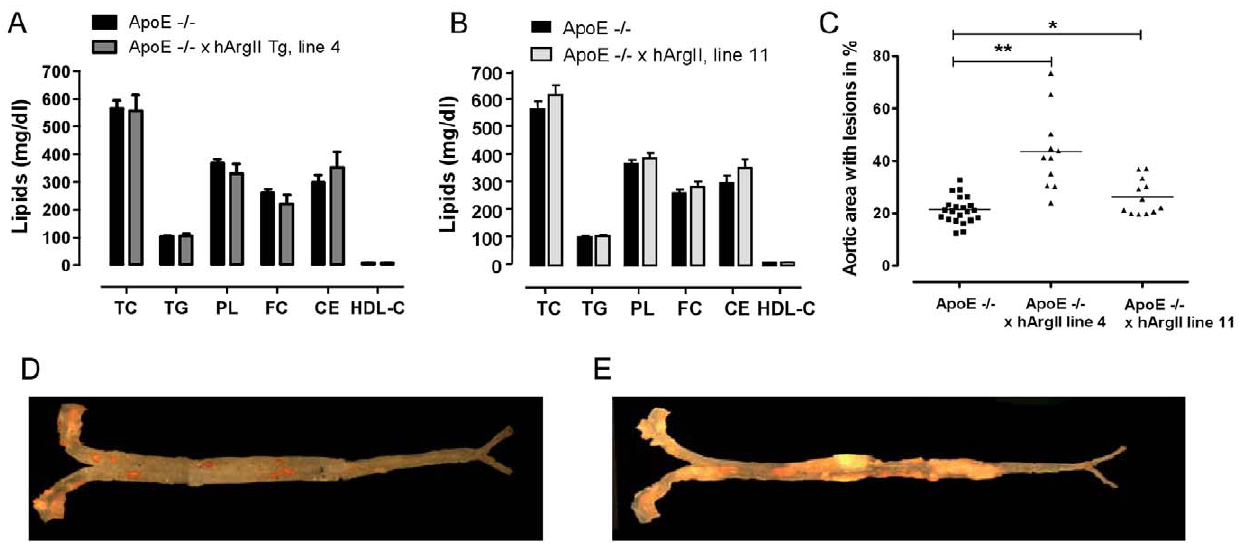
Figure 5. Plasma lipid profiles including total cholesterol (TC), triglycerides (TG), phospholipids (PL), free cholesterol (FC), cholesteryl esters (CE) and high density lipoprotein cholesterol (HDL-C) for female 8-month-old A ApoE 2 / 2 sibling control (n=21) and heterozygous and homozygous Line 4 hArgII x ApoE 2 / 2 mice (n=9) or B ApoE 2 / 2 sibling control (n=21) and heterozygous and homozygous Line 11 hArgII x ApoE 2 / 2 mice (n=19). C Plaque lesion area in aorta from 8-month-old female ApoE 2 / 2 sibling control (n=22) and heterozygous Line 4 hArgII x ApoE 2 / 2 females (n=11) and heterozygous and homozygous Line 11 hArgII x ApoE 2 / 2 females (n=12). Images of en face Sudan IV staining of atherosclerotic plaque in the whole aorta from 8-month-old D heterozygous Line 4 female hArgII x ApoE 2 / 2 and E ApoE 2 / 2 sibling control mouse. Data are presented as mean 6 SEM. Values were compared with either a unpaired Student’s t-test or a 1-way ANOVA with Bonferroni posthoc test where * = P , 0.05 and ** = P ,